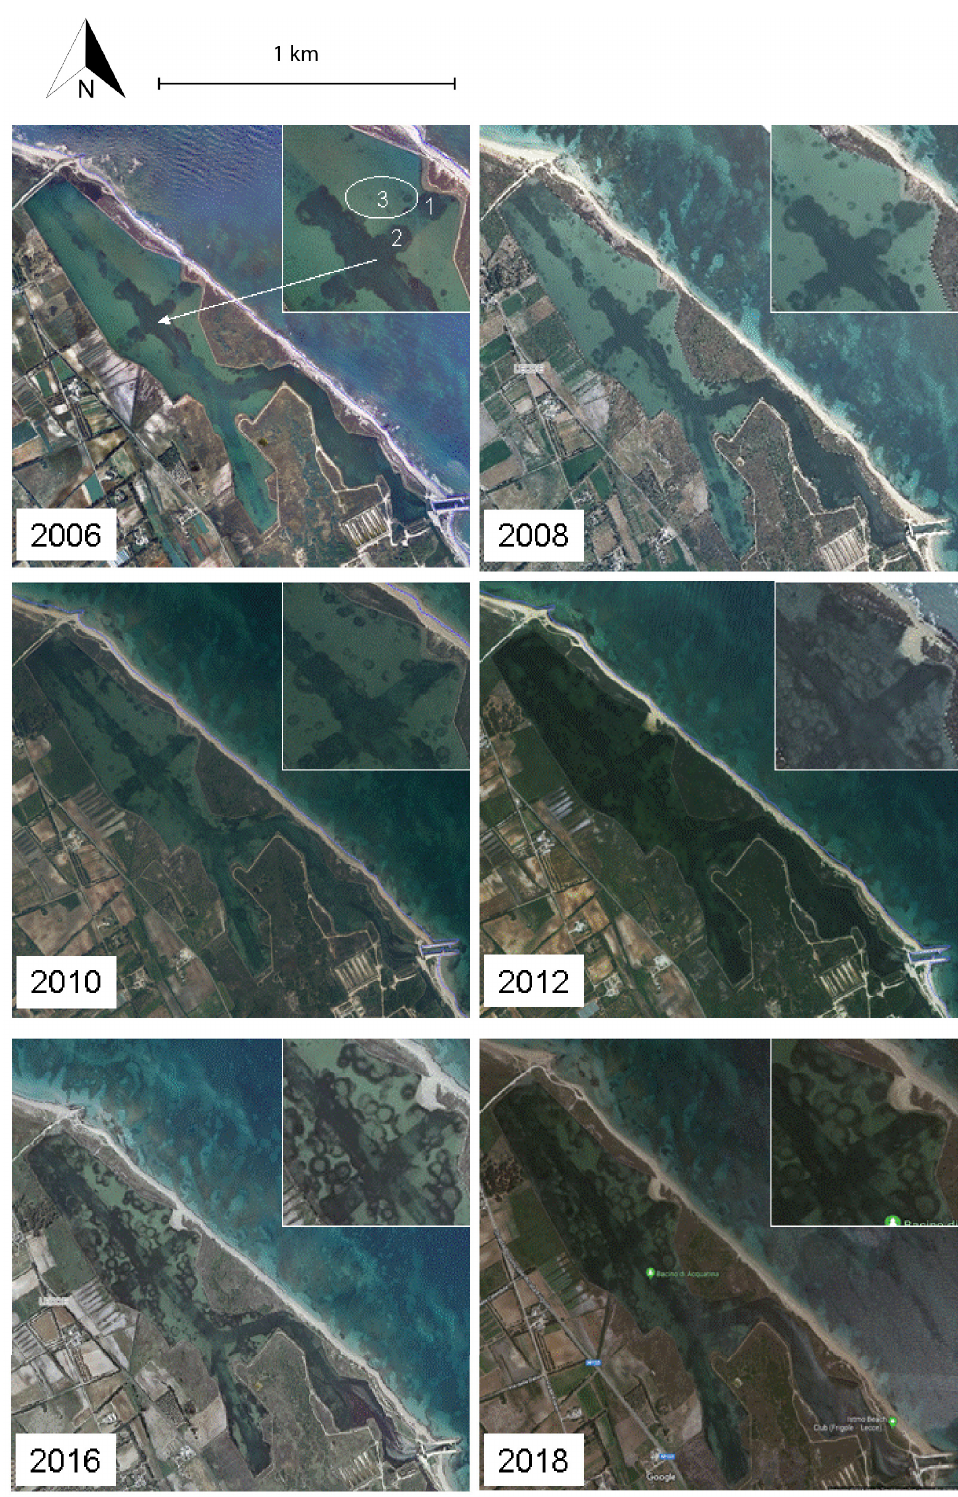
Figure 10. Sequence of aerial photographs (time span from 2006 to 2018), showing evolution of the sinkhole